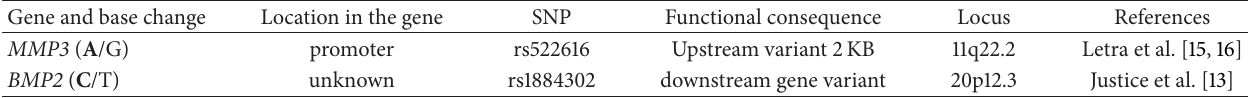
Figure 3: Pedigrees of the oligodontia family with arrows indicating the proband. Black figures = affected; open figures = unaffected; squares = males; circles = females. Table 1: Candidate gene markers